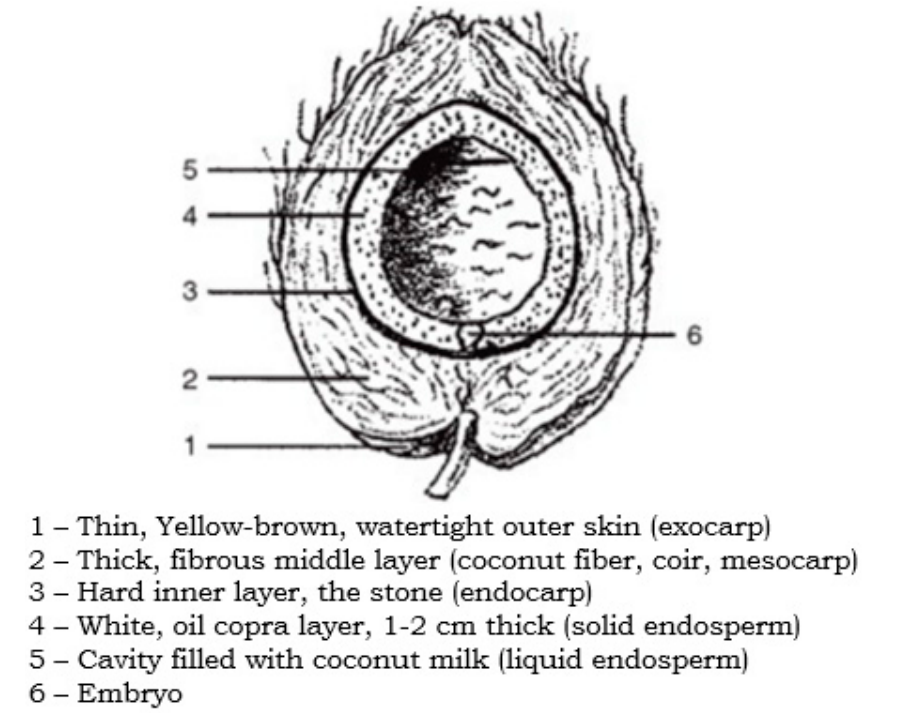
Figure 1. Coconut longitudinal section (adapted from [37]).